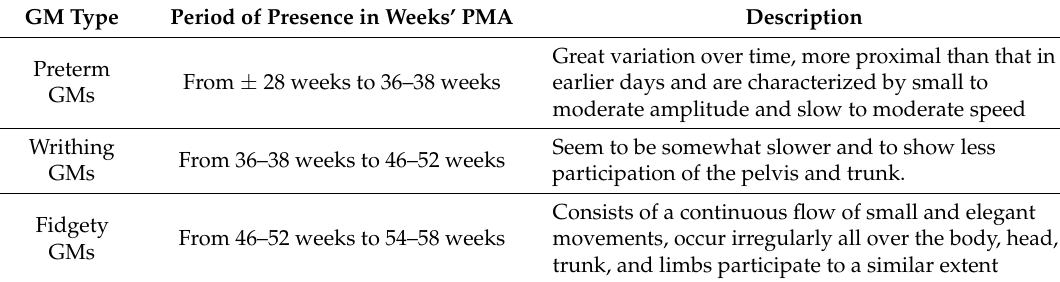
Table 5. Age-specific characteristics of normal